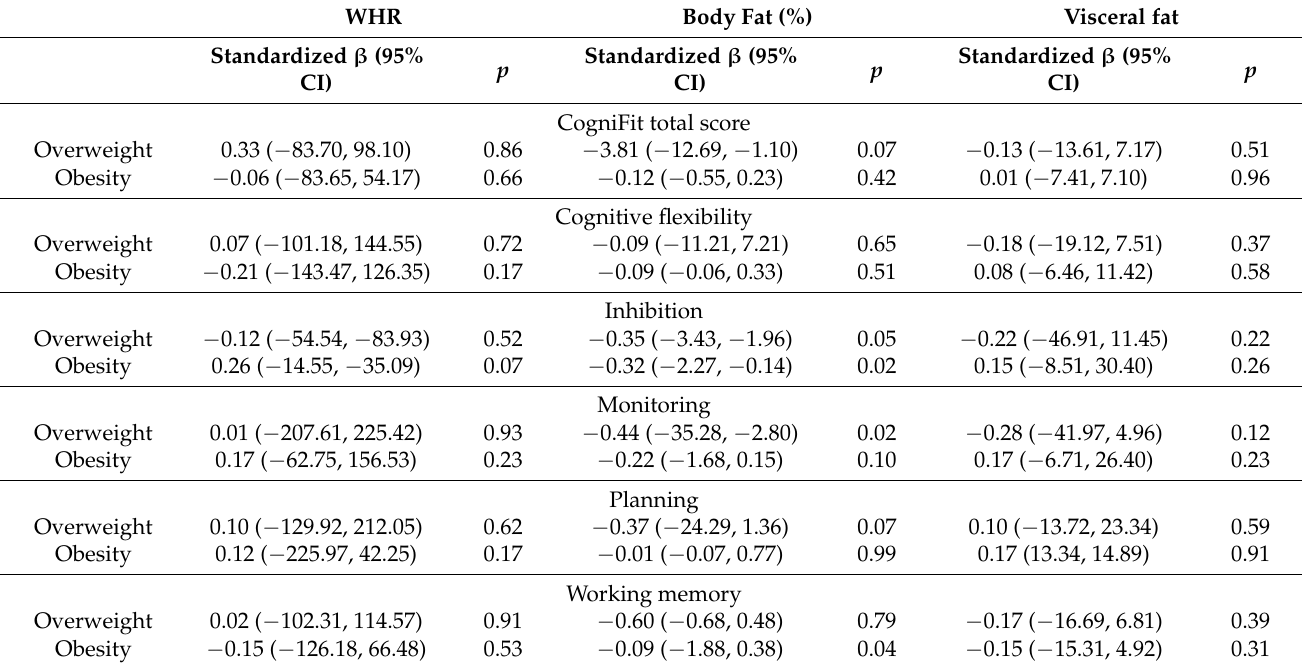
Table 4. Associations of executive function and markers of adiposity.